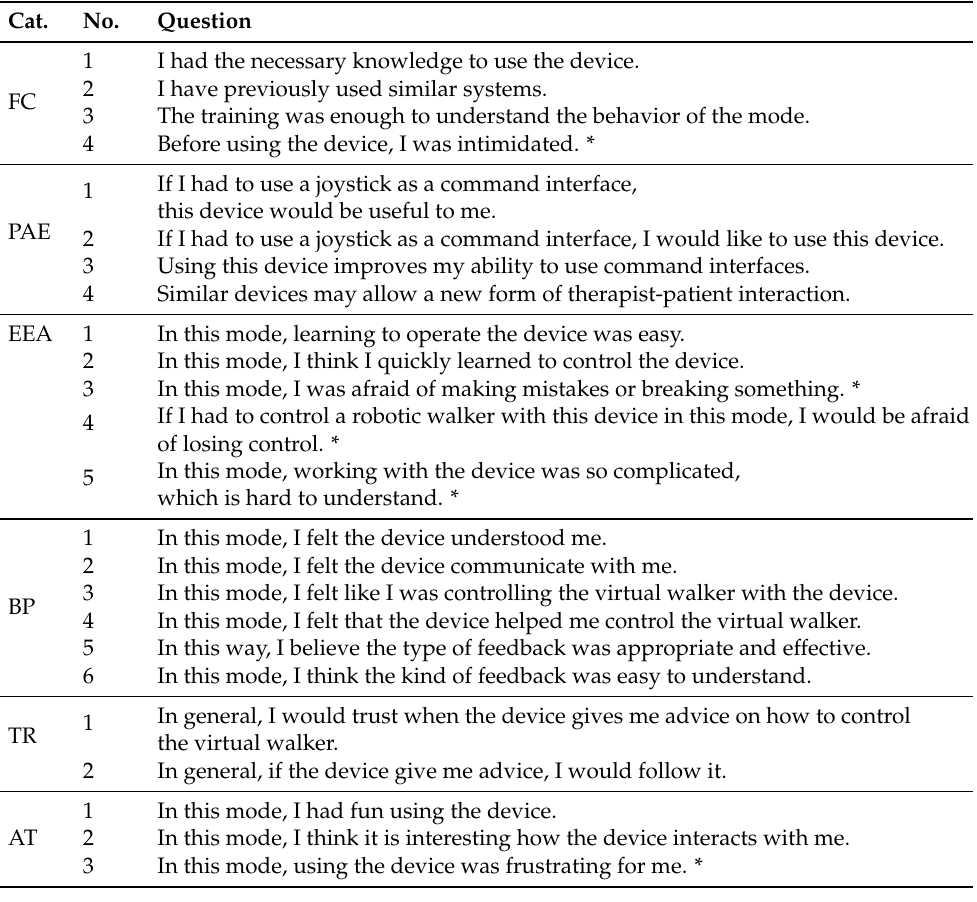
Table 2. Perception and usability questionnaire implemented in the experiment. Asterisks indicate that questions were formulated